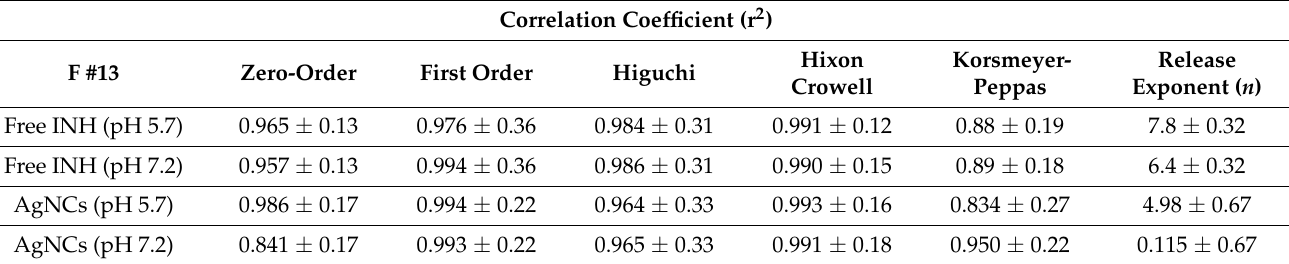
Table 2. In vitro release kinetics of SLN (Data are expressed as mean ± SD, n = 3). Correlation Coefficient (r 2 )